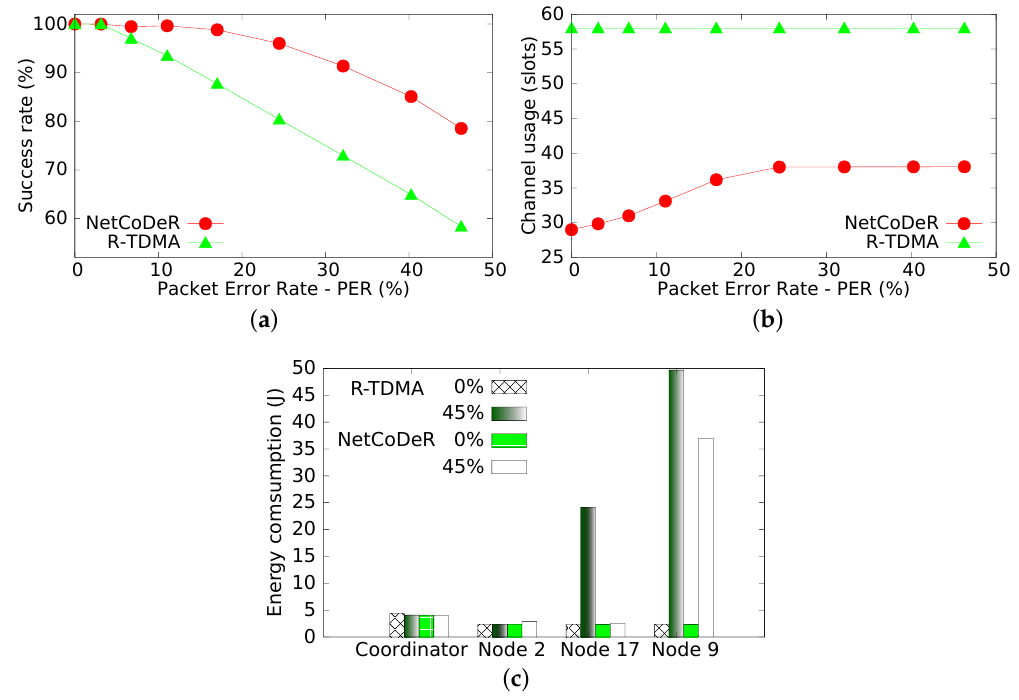
Figure 9. Simulation results. ( a ) Success rate (received/sent data); ( b ) Wireless media utilization; ( c ) Individual battery